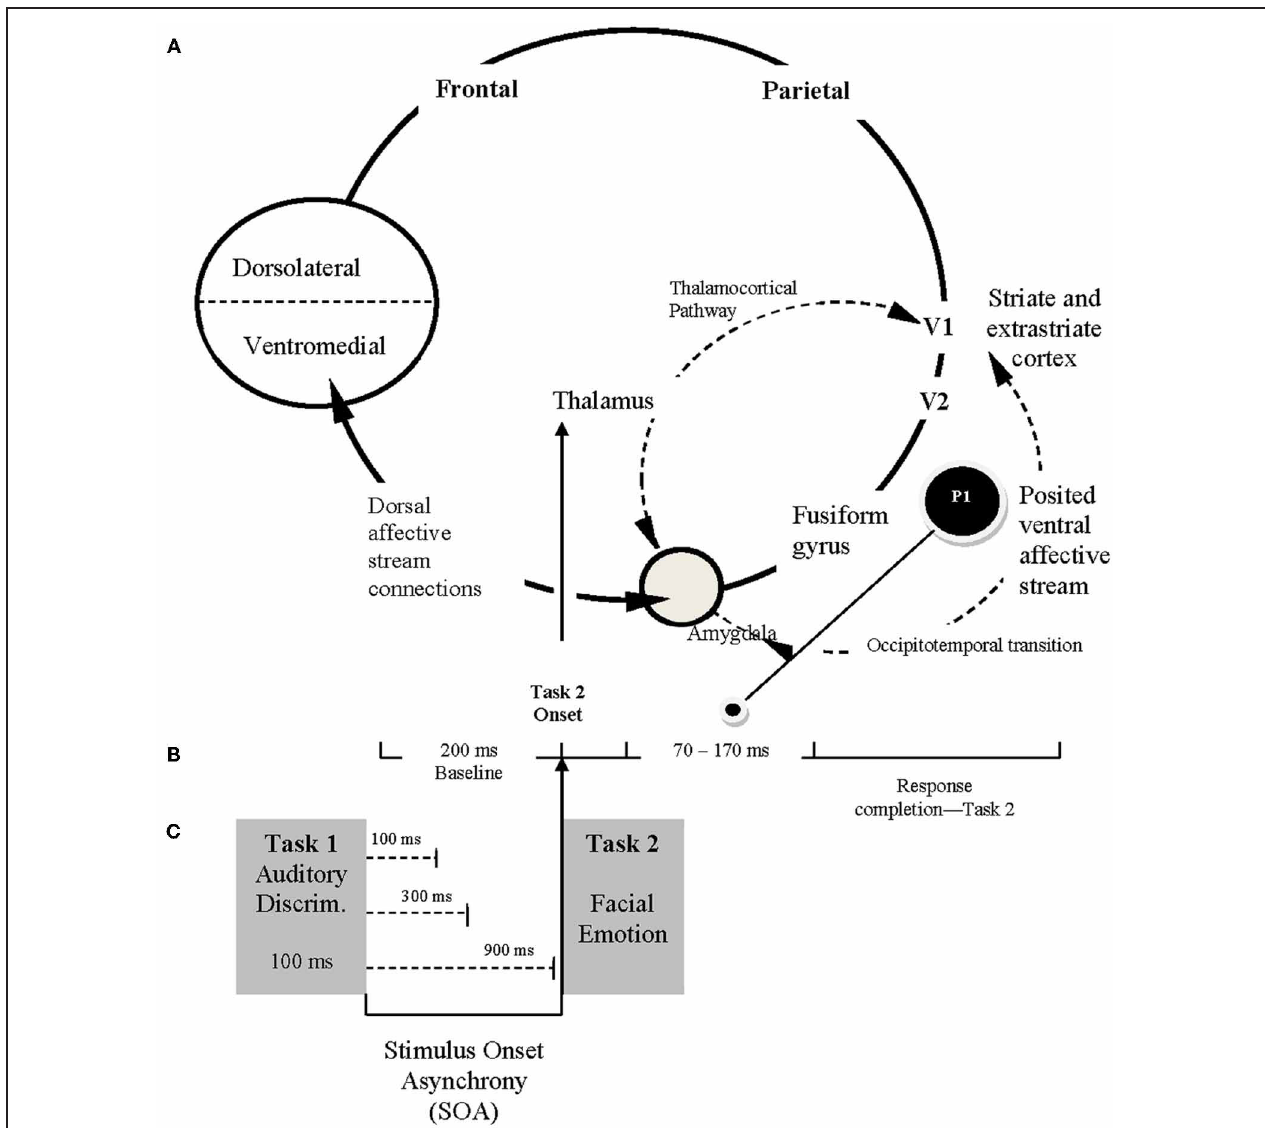
FIGURE 2 | Conceptual framework for ERP study. (A) The posited neural framework involved in processing facial emotion. The ventral affective stream (posterior system) involves reciprocal and neuromodulatory influences between the amygdala and extrastriate-fusiform gyrus network (occipitotemporal transition). The dorsal affective stream (anterior system), includes the amygdala and higher order interactions with prefrontal cortical regions (less emphasized in the current study). (B) Schematic illustration of